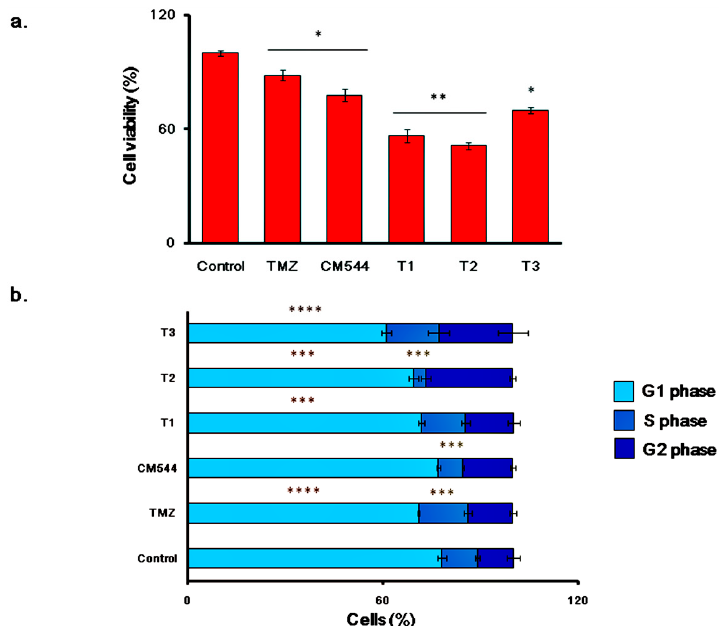
Figure 7. Cell metabolic activity and cell cycle progression of C6 rat glioma cells in the presence of TMZ and CM544. Metabolic activity of C6 rat glioma cells is expressed as the ratio (%) of untreated cells (Control) measured by the MTT test ( a ). Results represent the means ± S.D. ( n = 9). Control (untreated cells); TMZ (500 µ M TMZ 24 h); CM544 (1.5 mM CM544 24 h); T1 (500 µ M TMZ 48 h); T2 (1.5 mM CM544 48 h); T3 (1.5 mM CM544 24 h as pre-incubation; 500 µ M TMZ + 1.5 mM CM544 24 h). * p < 0.05 TMZ, CM544 and T3 vs. Control; ** p < 0.005 T1 and T2 vs. Control; ** p < 005 T1 vs. TMZ and T2 vs. CM544. ( b ) Cell percentages in the various phases of the cell cycle (G1, S and G2) of C6 rat glioma cells. Results represent the means ± S.D. ( n = 3). Samples were named as for the MTT assay. *** p < 0.002 G1 phase of T1 and T2 vs. Control; *** p < 0.002 S phase of TMZ, CM544 and T2 vs. Control; *** p < 0.002 S phase CM544 vs. TMZ; *** p < 0.002 S phase of T2 vs. T1 and T3. **** p < 0.0005 G1 phase of TMZ and T3 vs. Control; **** p < 0.0005 G1 phase of T3 vs. TMZ, CM544, T1 and T2.